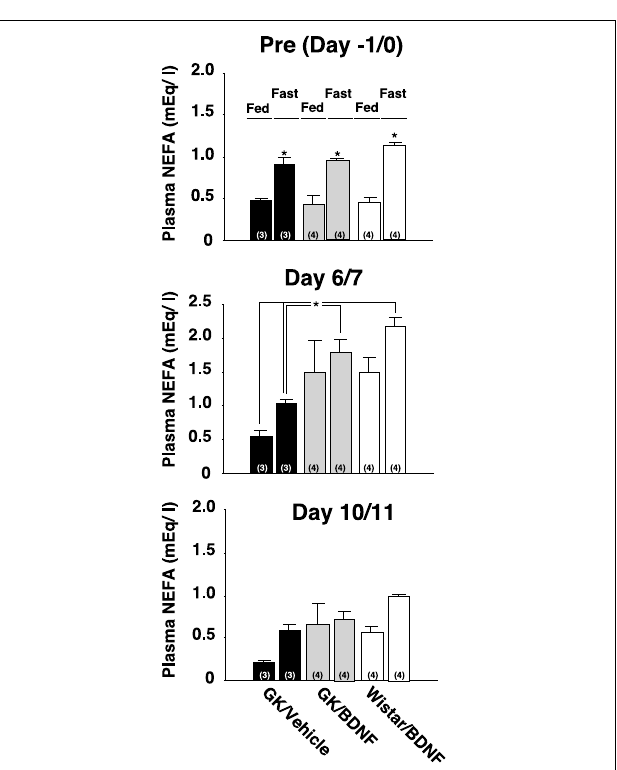
FIGURE 8 | Effect of BDNF on NEFA levels before and after treatment to GK rats in fed and fasted conditions. Plasma NEFA levels in fed and 12h-fasted conditions at time points before treatment (Day –1/0), immediately after termination of treatment (Day 6/7), and 4/5 days after termination of treatment (Day 10/11) were measured. Plasma NEFA level was higher in fasted condition at all time points measured in all groups [Pre(Day –1/0), p < 0 . 05 vs. fed conditions, Two-Way ANOVA with Tukey’s post-hoc test]. At time point immediately after termination of treatment (Day 6/7), plasma NEFA levels in Wistar-BDNF and GK-BDNF groups were increased both at fed and fasting conditions. Especially, plasma NEFA levels in Wistar-BDNF and GK-BDNF groups at fasting condition were significantly higher than those in GK-Vehicle group at fasting condition ( ∗ p < 0 . 05, Two-Way ANOVA with Tukey’s post-hoc test). Such tendency continued to Day 10/11 but there was no significant difference at this time